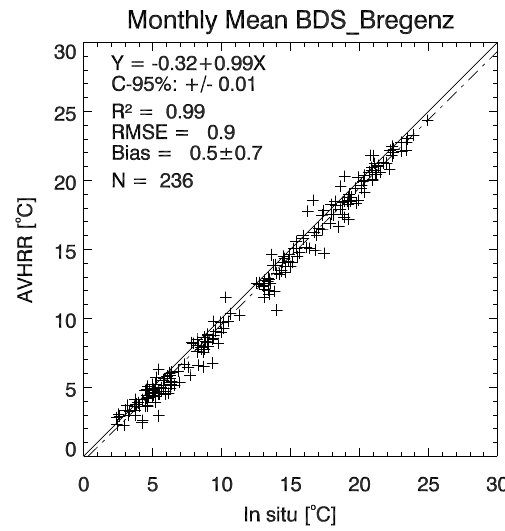
Figure 8. Comparison of monthly mean water temperatures derived from in situ and satellite observations at Lake Constance between 1989 and 2009. The statistical parameters are described in Fig. 5.